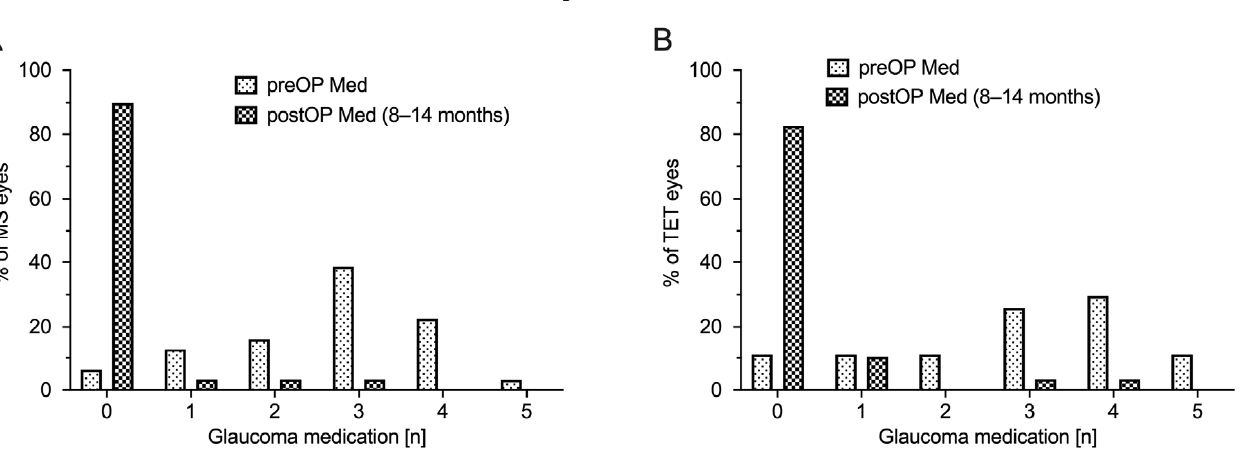
Figure 3. Number of antiglaucomatous medications. Number of antiglaucomatous medications preoperatively and one year postoperatively. ( A ) MS = MicroShunt implantation and ( B ) TET = trabeculectomy. PreOP = preoperative; postOP = postoperative.